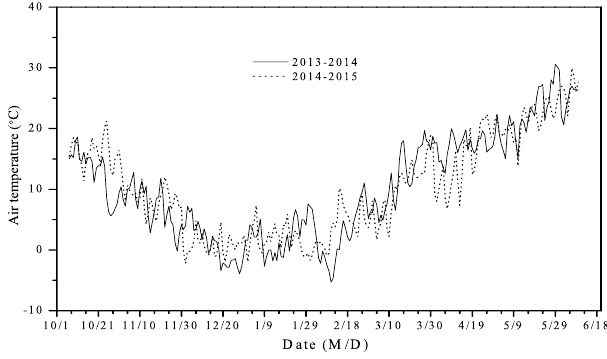
Figure 1. Air temperature in 2013–2014 and 2014–2015 winter wheat growing